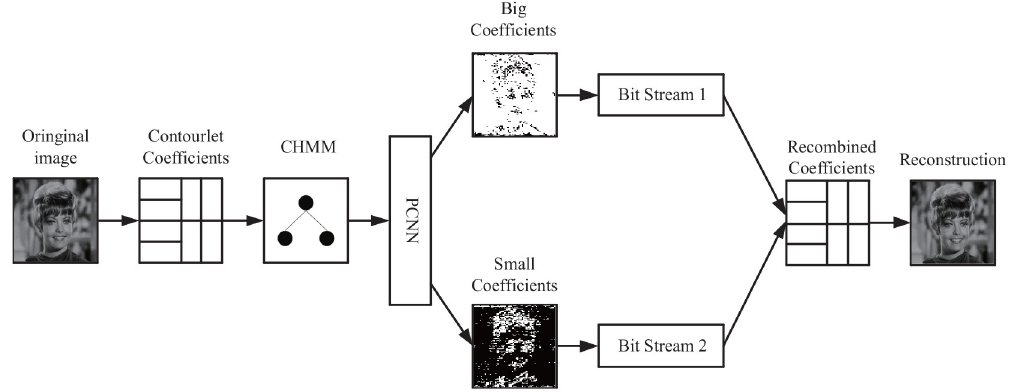
Fig 11. Hybrid HMM–PCNN model in the contourlet domain for the SPIHT algorithm, where CHMM denotes the HMM in the contourlet domain. Reprinted from [40] under a CC BY license, with permission from IEEE publisher, original copyright